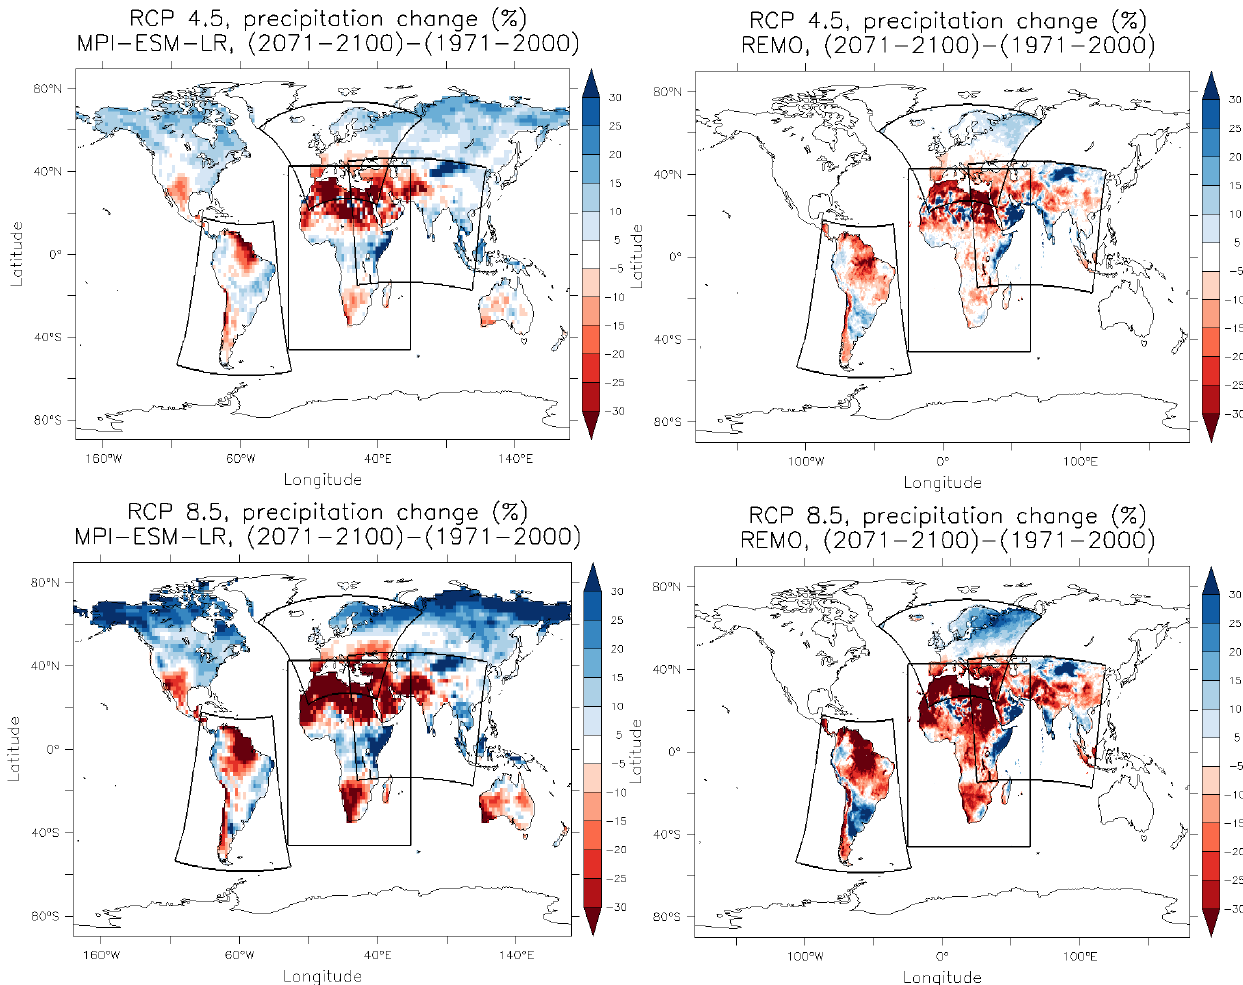
Figure 5. MPI-ESM (LR) and REMO climate change signals for annual precipitation sums. The climate change signal for precipitation is plotted in mm/day as simulated by the Earth system model MPI-ESM (LR) (left panels) and the regional climate model REMO (right panels). In the upper panels the climate change signal for RCP 4.5 is shown, while the lower panels show the climate change signals for RCP 8.5. The future time period 2071–2100 is compared to the reference time period